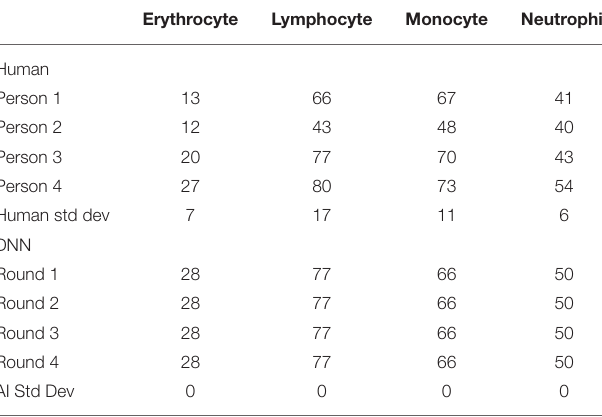
FIGURE 3 | The DNN model’s training accuracy shows its precision vs. the number of iteration steps. As can be seen that the graph takes on a 1/x, asymptotic relationship with saturation quickly established within the first few thousand steps. After 200,000 iterations, the precision % has not improved that much and the training of the model stopped, which took around 2 days of nonstop training. DNN, deep neural network. TABLE 1 | The number of cells labeled in the validation dataset between human and AI for each cell